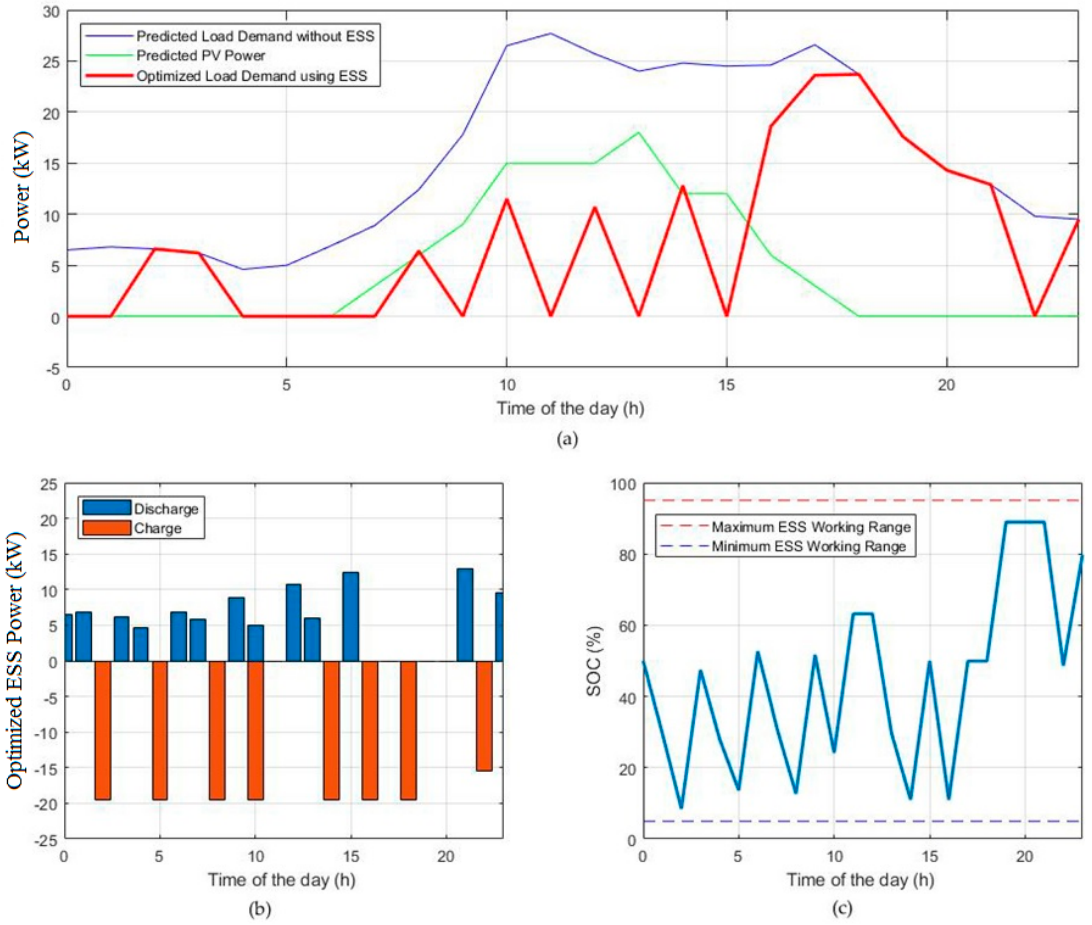
Figure 7. The optimized operation schedule. ( a ) Power; ( b ) Optimized ESS Power; ( c ) Social Overhead Capital (SOC).